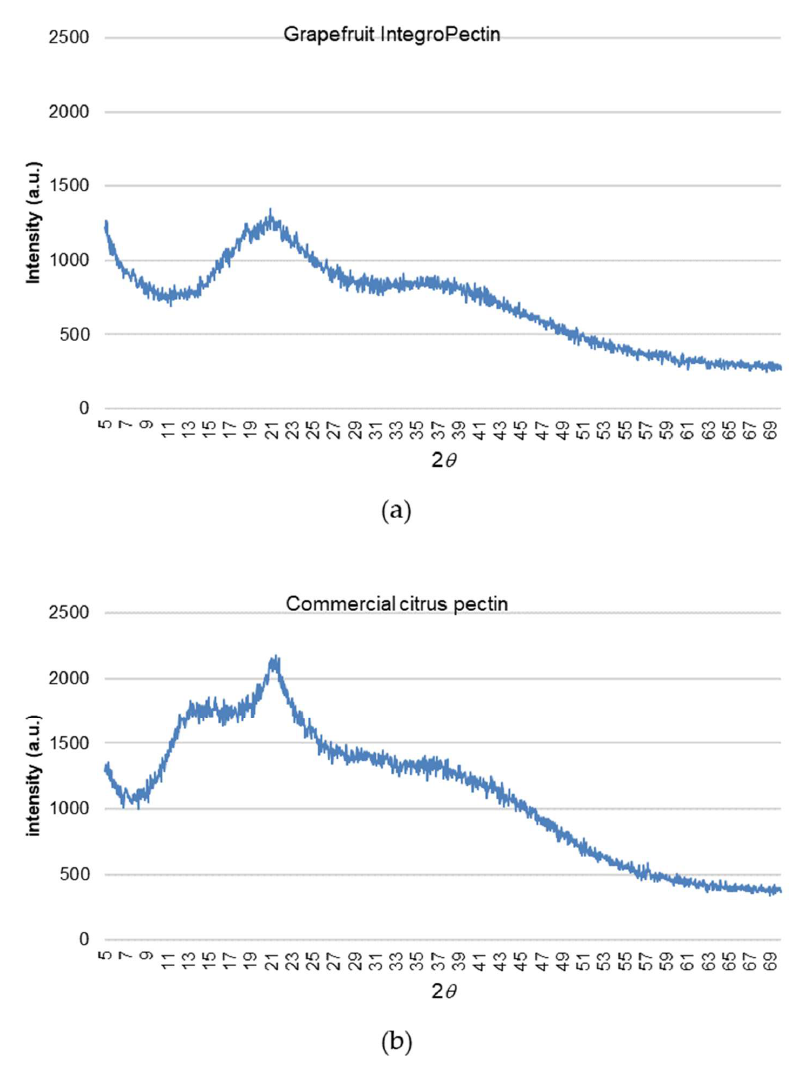
Figure 6. X-ray diffractograms of grapefruit IntegroPectin ( a ) and commercial citrus pectin ( b ).